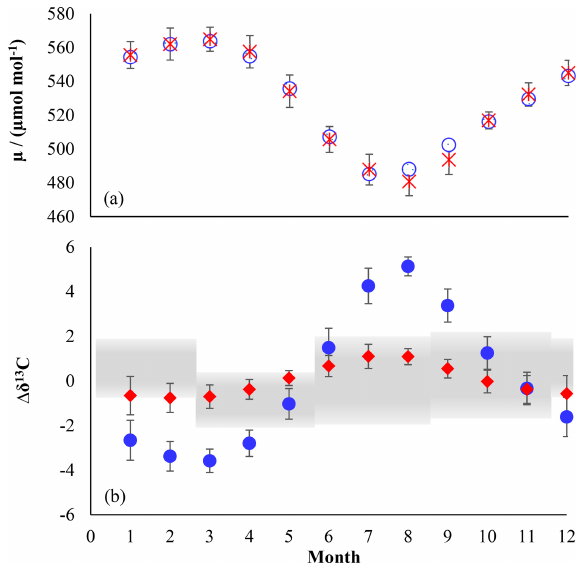
Figure 2. (a) Comparison of modelled northern hemispheric mixing ratios (blue open diamonds) with measured mixing ratios at Mace Head, Ireland (red crosses) for the period from 2004 to 2014 (Prinn et al., 2000). Error bars indicate the variations in the monthly means on the 1 σ level. (b) Modelled seasonal fluctuations in the δ 13 C of northern hemispheric CH 3 Cl using an ε of − 11 . 2‰ (red filled dia- monds) and an ε of − 59‰ (blue filled dots) as reported by Gola et al. (2005). The panel shows monthly averages from a 10-year sim- ulation with seasonal variations of up to ± 10‰ in the combined isotopic source signature. Error bars indicate the variations in the monthly means on the 1 σ level. The grey shaded area shows re- ported seasonal variations (seasonal mean ± 1 σ ) from Thompson et al. (2002).